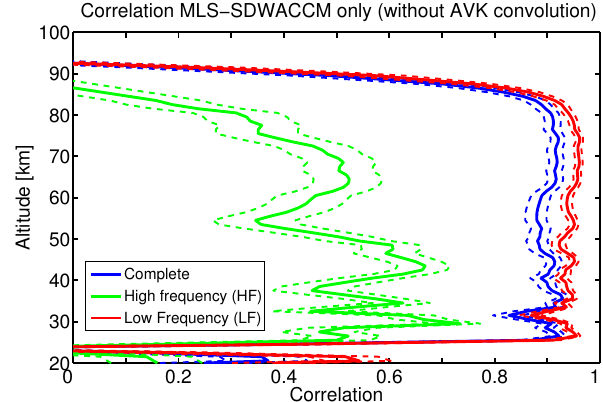
Fig. 7. Altitude profiles of the MLS-SDWACCM correlation co- efficients for the complete time series, for the high-frequency part alone, and for the low-frequency part alone. MLS and SDWACCM data have not been convolved with the KIMRA AVK, so that these correlation coefficients are not restricted to the coarse vertical reso- lution of